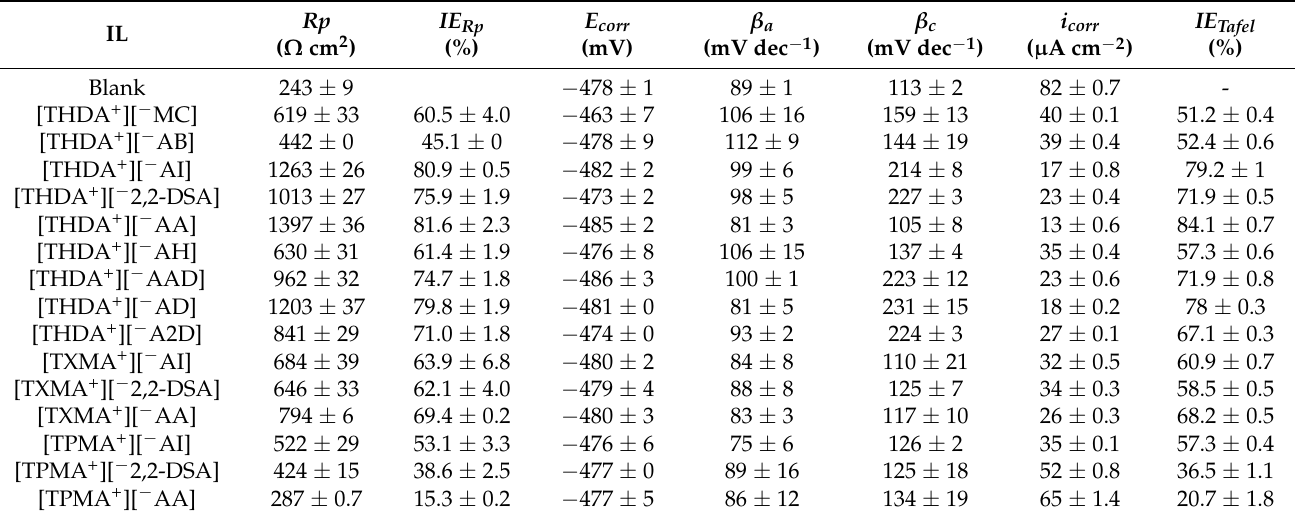
Table 2. Electrochemical parameters for API X52 steel in 0.5 M HCl at 100 ppm of